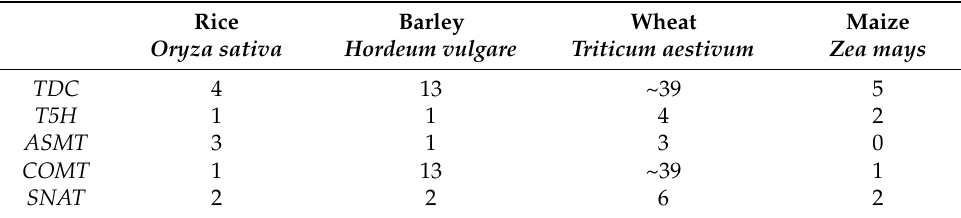
Table 1. Number of genes for the melatonin biosynthesis pathway in four major cereal crops. Rice